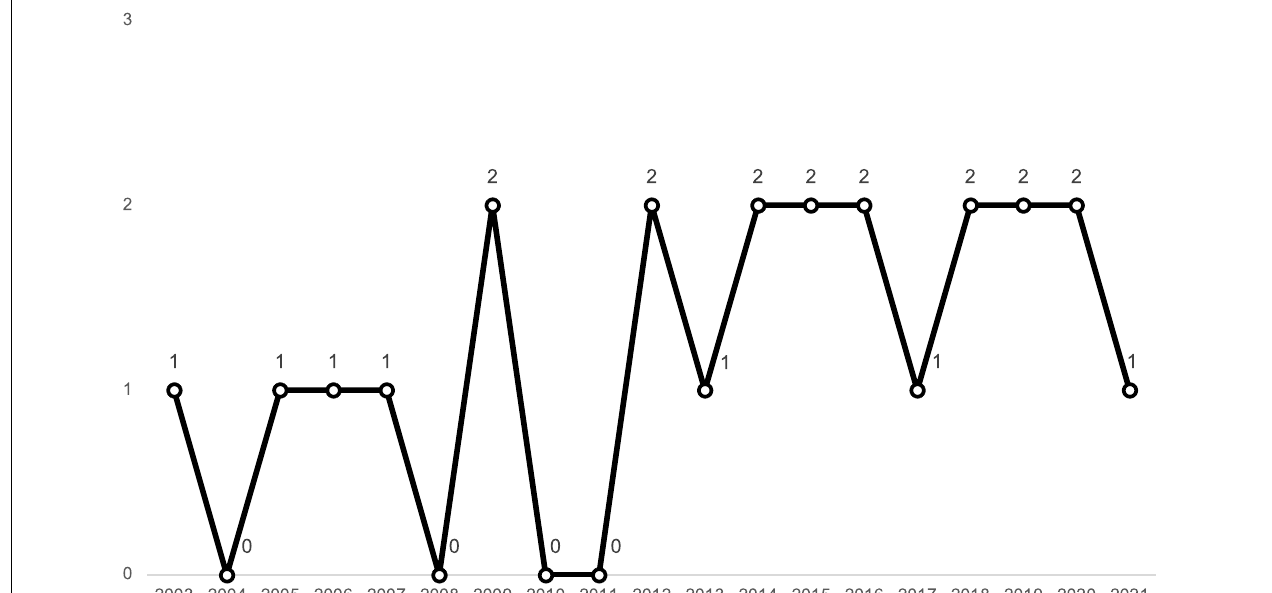
FIGURE 2 | Number of sample papers published by